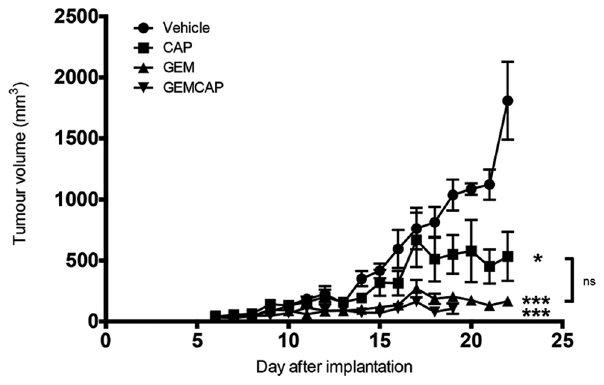
Figure 5. Anti-tumour effect of the GEMCAP combination in KPC allograft. GEMCAP combination efficacy in mice bearing KPC allograft tumours. Animals received vehicle or GEM every 3 days at 75 mg/kg or CAP at 539 mg/kg, 5 days per week or a combination of these two doses. Tumour volumes are represented as the mean 6 SEM (n=5 per group; *p , 0.05, ***p , 0.001 when compared to vehicle; ns: not significant).